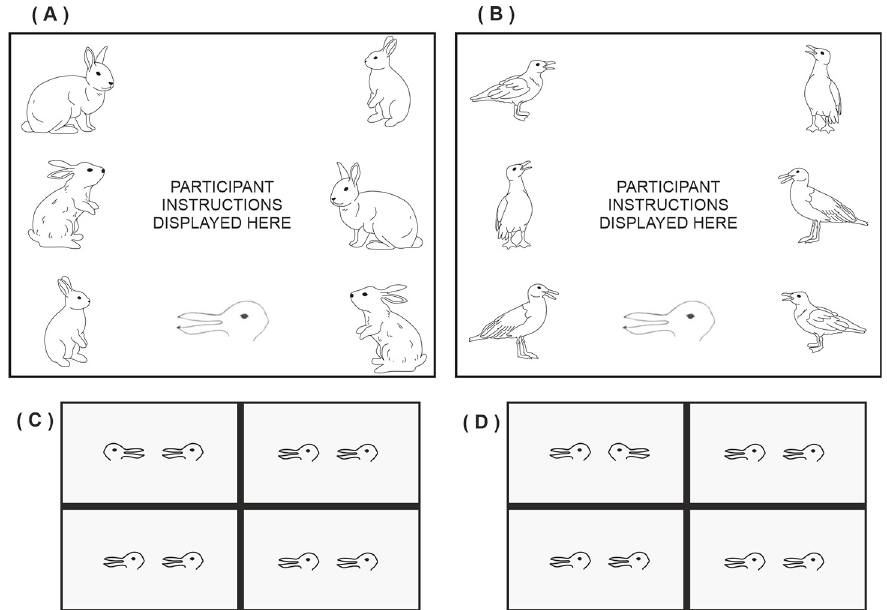
Fig 13. Examples of semantic priming on the instruction screen for the rabbit (A) and seagull (B) conditions in Experiment 5. Each of the six figures would appear randomly one by one. Schematic of the visual search task in a seagull inwards (C) and seagull outwards (D)